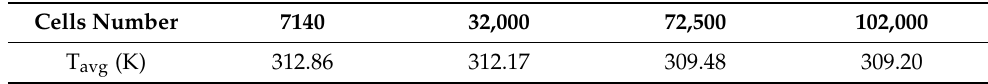
Table 2. Mesh independence study in terms of the bed T avg